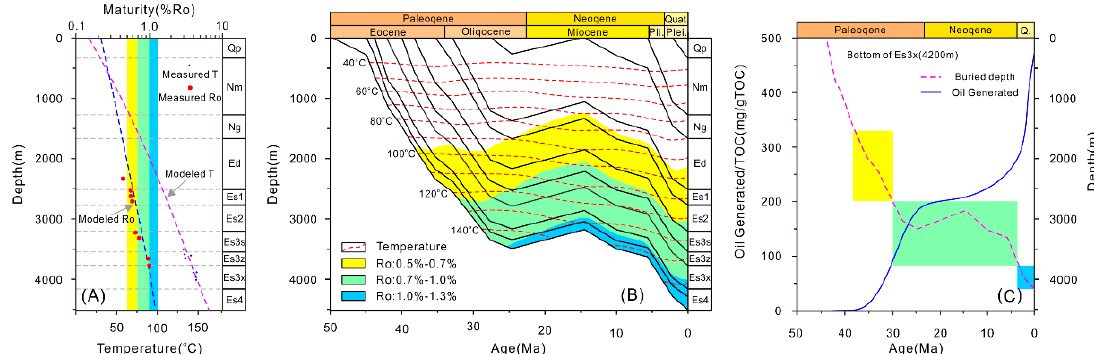
Figure 14. Modeling results for well X99 in the Linnan Sag. ( A ) Modeled maturity and temperature of well X99 in the Linnan Sag. The modeled vitrinite reflectance and temperature versus depth curve fit well with the measured data. ( B ) Maturation and burial history of X99 in the Linnan Sag. ( C ) History of oil generation from the third member of the Shahejie Formation (Es3). Ro = vitrinite reflectance; T = temperature. The location of the well is shown in Figure 1C.